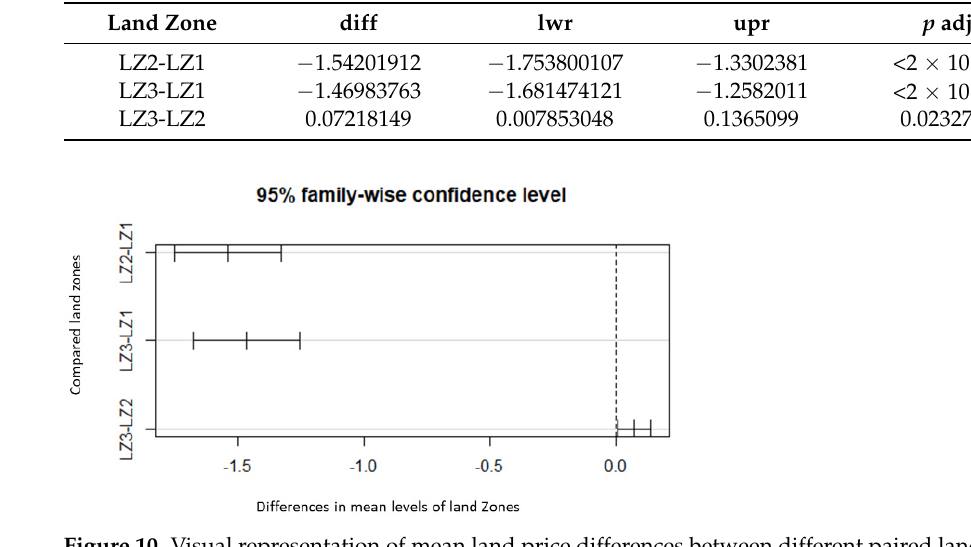
Figure 10. Visual representation of mean land price differences between different paired land zones. LZ3-LZ2 is a comparison between Land Zone 3 and Land Zone 2, LZ3-LZ1 is a comparison between Land Zone 3 and Land Zone 1, and LZ2-LZ1 is a comparison between Land Zone 2 and Land Zone 1.